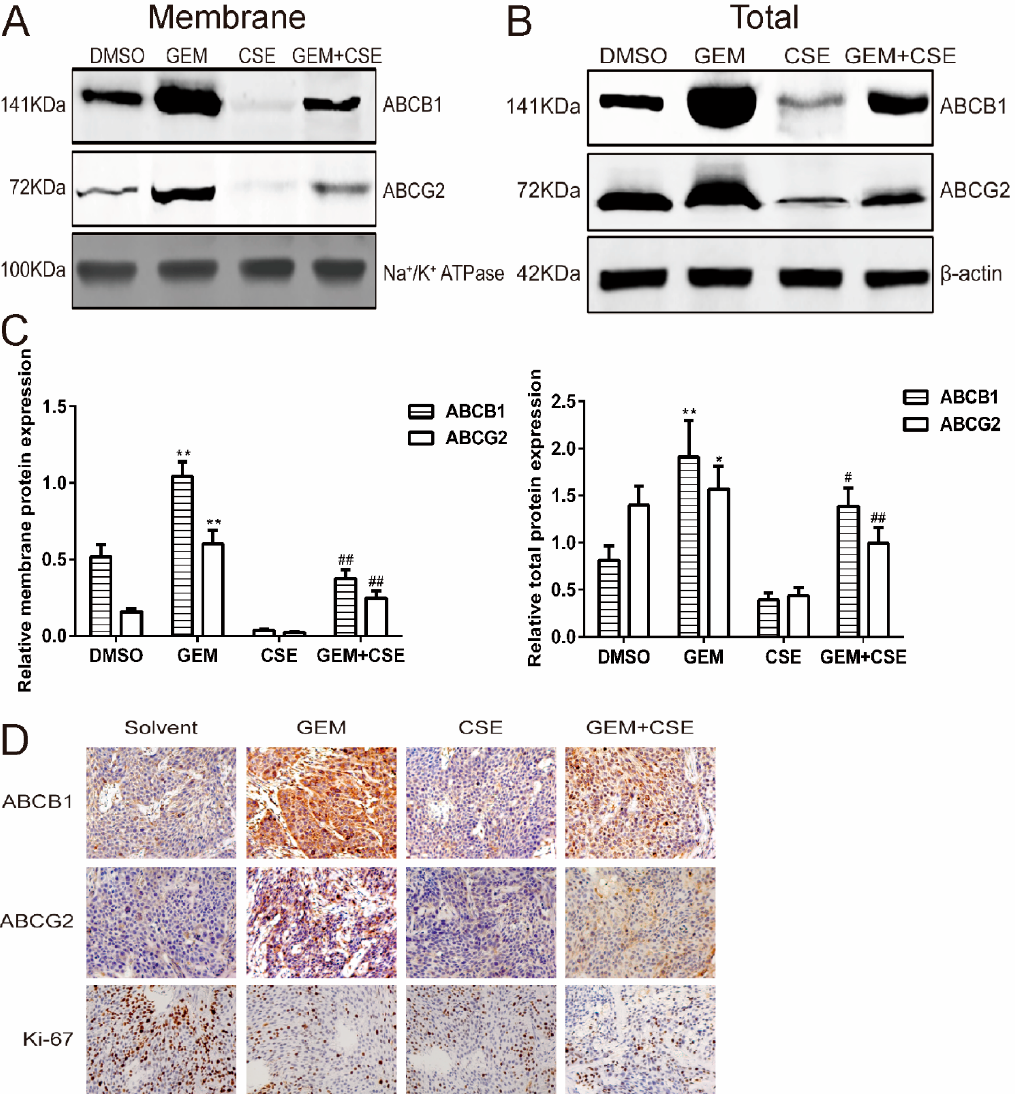
Figure 6. Coix seed extract reverses gemcitabine induced upregulation of ABCG2 and ABCB1 protein in vitro and in vivo . Results are representative of at least three independent experiments. (A) The coix seed extract induces downregulation of membrane ABCG2 and ABCB1 protein expression in BxPC-3 luc cells. Na + /K + ATPase was utilized as loading control. (B) The coix seed extract induces downregulation of total ABCG2 and ABCB1protein expression in BxPC-3 luc cells. β -actin served as loading control. (C) Relative integrated optical density (IOD) of ABCG2 and ABCB1 protein expression in membrane and total protein proportion of BxPC-3 luc cells. n = 3, mean ± SD. ** p < 0.01 vs. DMSO; * p < 0.05 vs. DMSO; ## p < 0.01 vs. gemcitabine (GEM) treatment; # p < 0.05 vs. gemcitabine